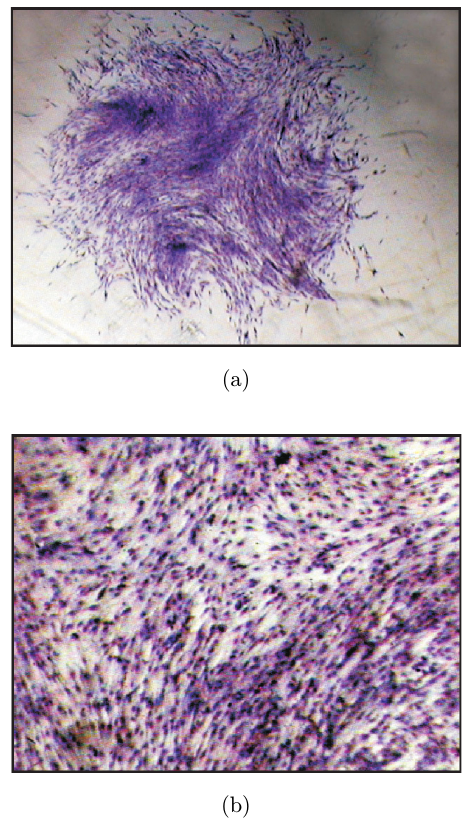
Fig. 2. Clone colony (a) formed by marrow stromal precursor cells in a monolayer culture and the structure of colony